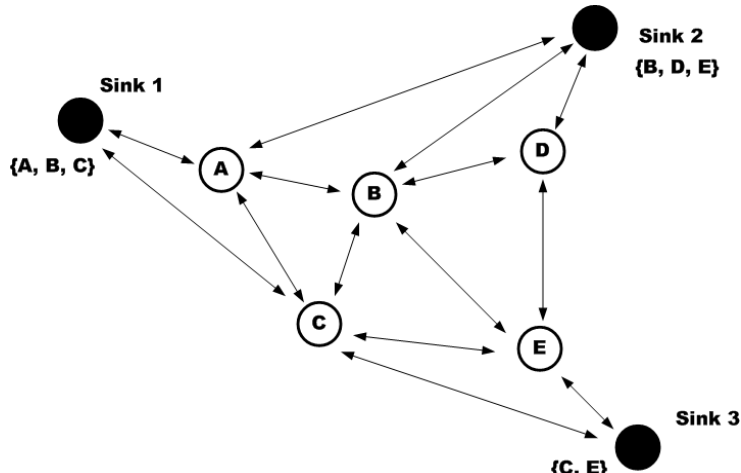
Figure 12. Using multiple sinks for data routing.